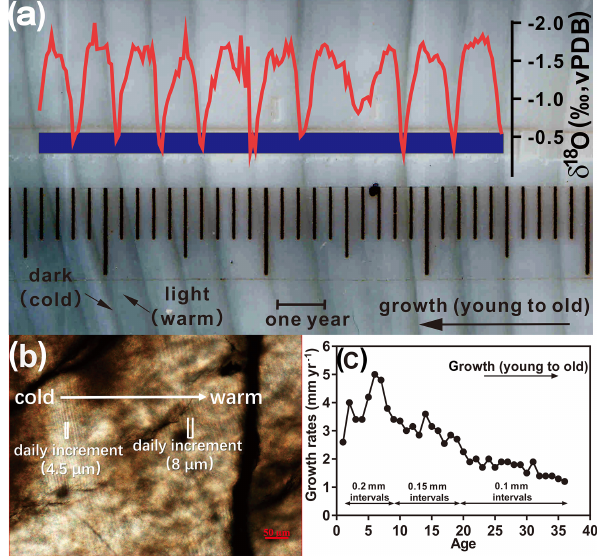
Figure 3. (a) Dark–bright lines consistent with δ 18 O A5 profiles. The blue line represents the sampling line. Dark and bright lines correspond to high δ 18 O (cold seasons) and low δ 18 O (warm sea- sons), respectively. The distance between the dashed lines repre- sents one year, during which the Tridacna grew. (b) Under the mi- croscope, daily increments (a dark coupled with a bright increment) are smaller when temperature is cold but larger when temperature is higher. (c) Growth rates (line 2 in Fig. 1c) in fossil Tridacna